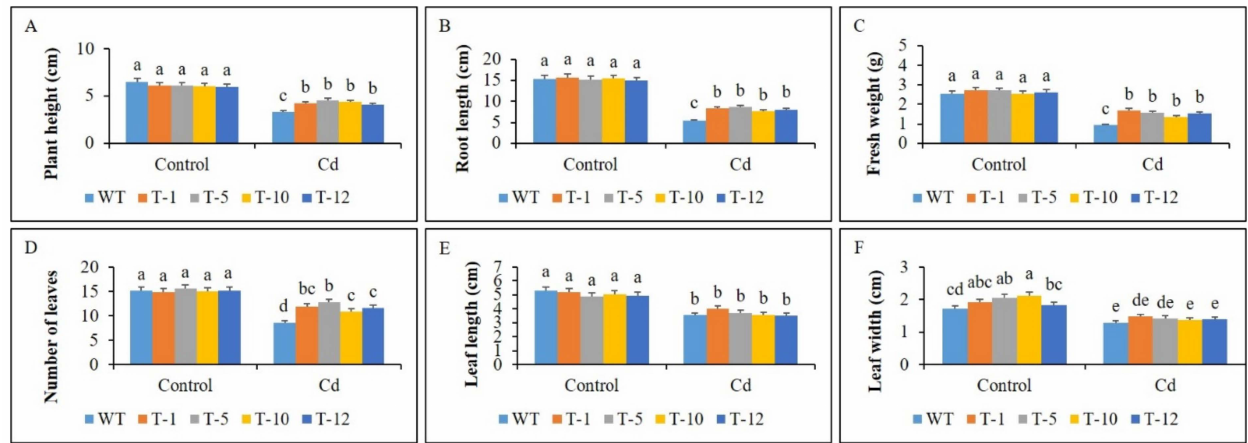
Figure 3. Comparison of plant growth traits ( A – F ) in WT and transgenic petunia cv. ‘Mirage Rose’ plants under control and cadmium (Cd) stress conditions. Data were collected on the 30th day of the experiment. Data represent the means of three replicates and error bars indicate standard error. Means with the same letters are not significantly different by least significant difference test (LSDT, p <